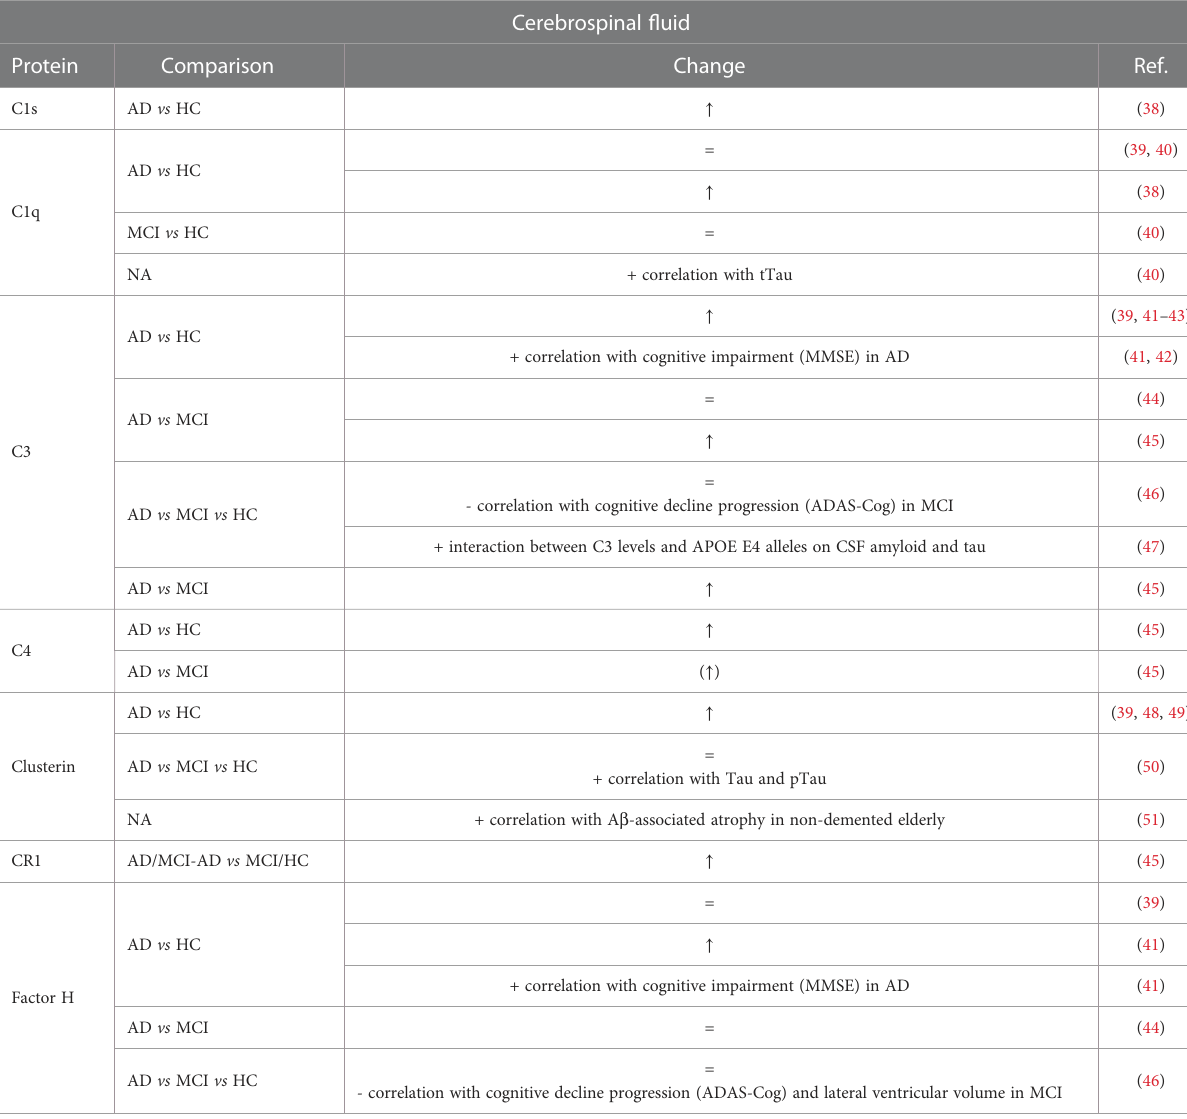
TABLE 1 Overview of changes and biomarker potential of complement proteins in the cerebrospinal fl uid (CSF) of mild cognitive impairment (MCI) and Alzheimer ’ s disease (AD) patients compared to a control group.